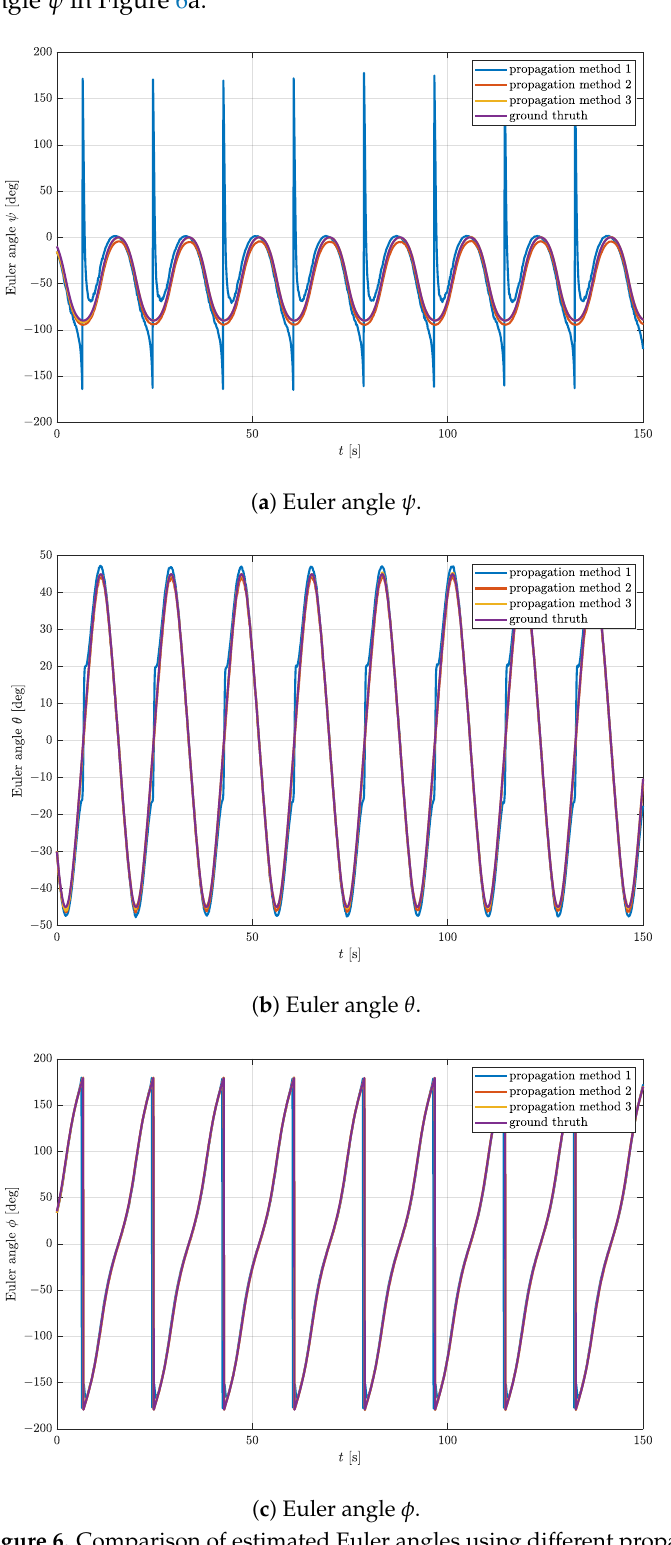
Figure 6. Comparison of estimated Euler angles using different propagation methods and comple- mentary filter with parameters µ = 0.7, N max = 20, G max = 1 × 10 − 2 , and K =